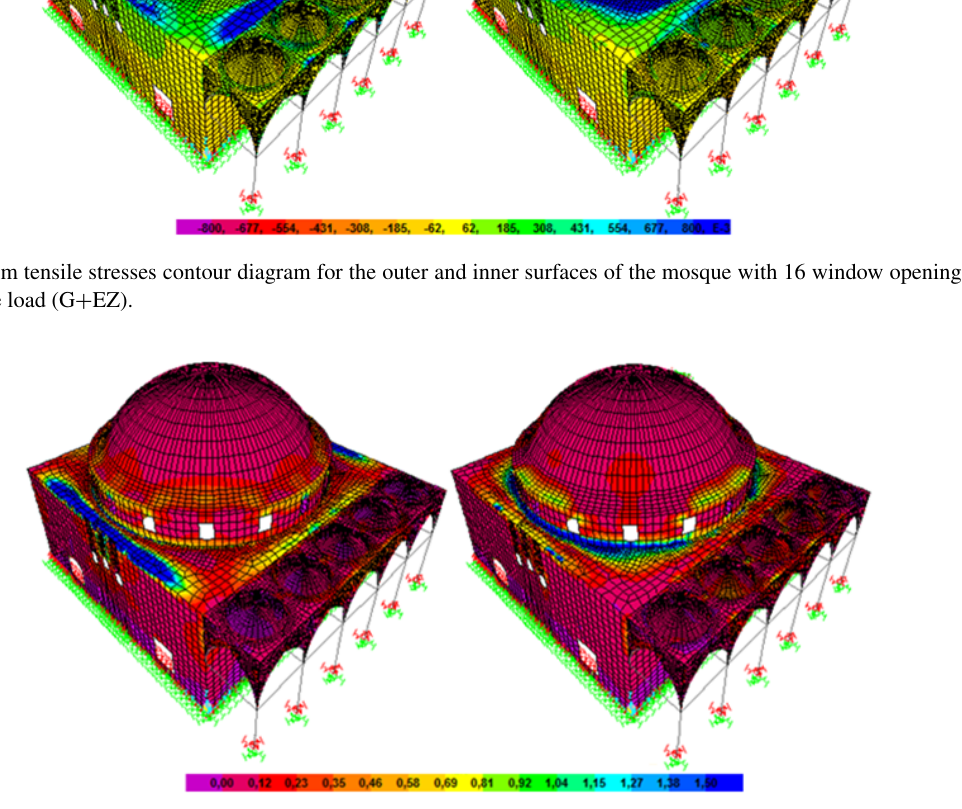
Figure 15. Maximum compression stresses contour diagram for the outer and inner surfaces of the mosque with 16 window openings under dead load and earthquake load (G + EZ).